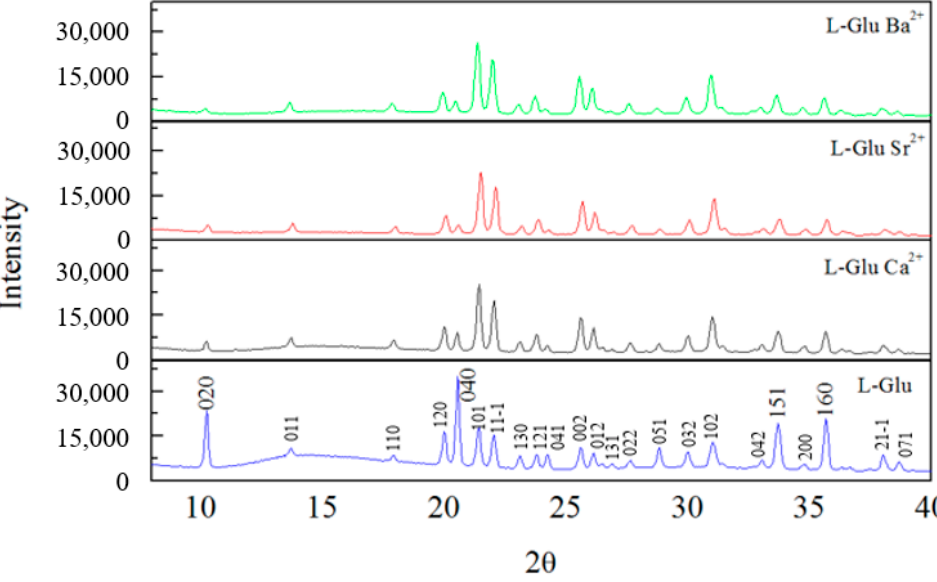
Figure 4. XRD spectra of L-glu and L-glu crystallized with barium, strontium and calcium ions.